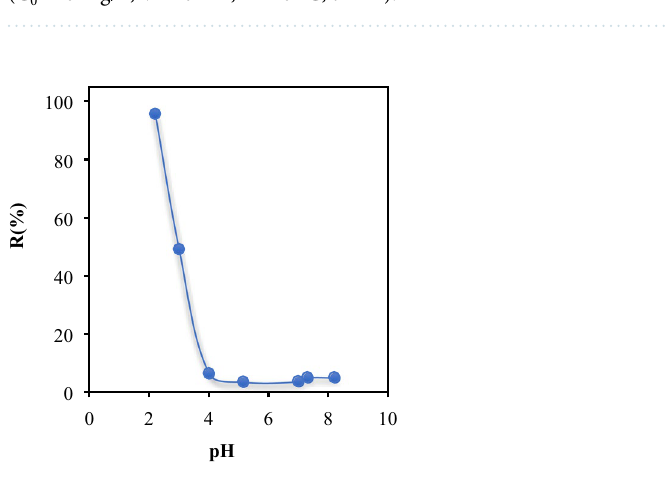
Figure 5. Effect of the dose of the adsorbent on the rate and quantity of adsorption dye CB by bean peel (BP) (C 0 = 25 mg/L, V = 25 mL, T = 25 °C, t = 2 h).